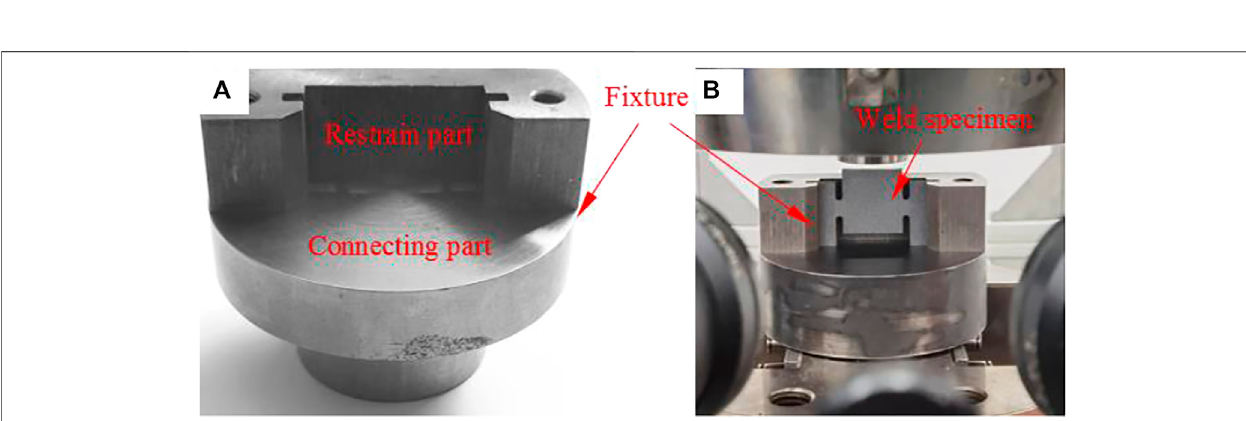
FIGURE 2 | Fixture design: (A) fi xture and (B) clamping relationship between the weld specimen and fi xture.